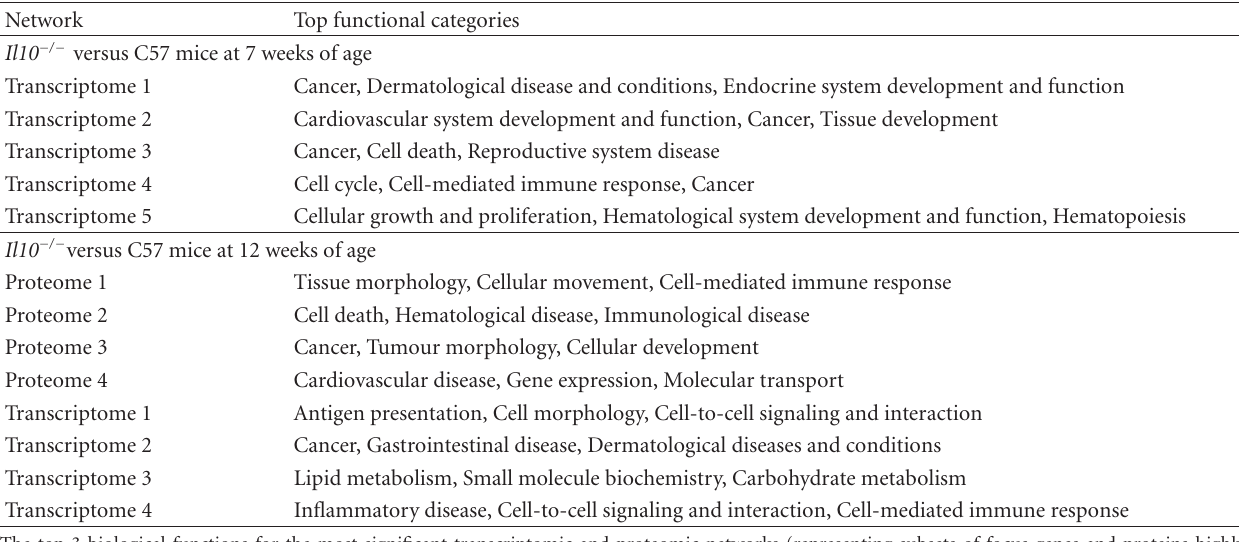
Table 6: Proteome and transcriptome network analysis for expression profiles from the colon of 7- and 12-week-old Il10 − / − mice compared to C57 mice using